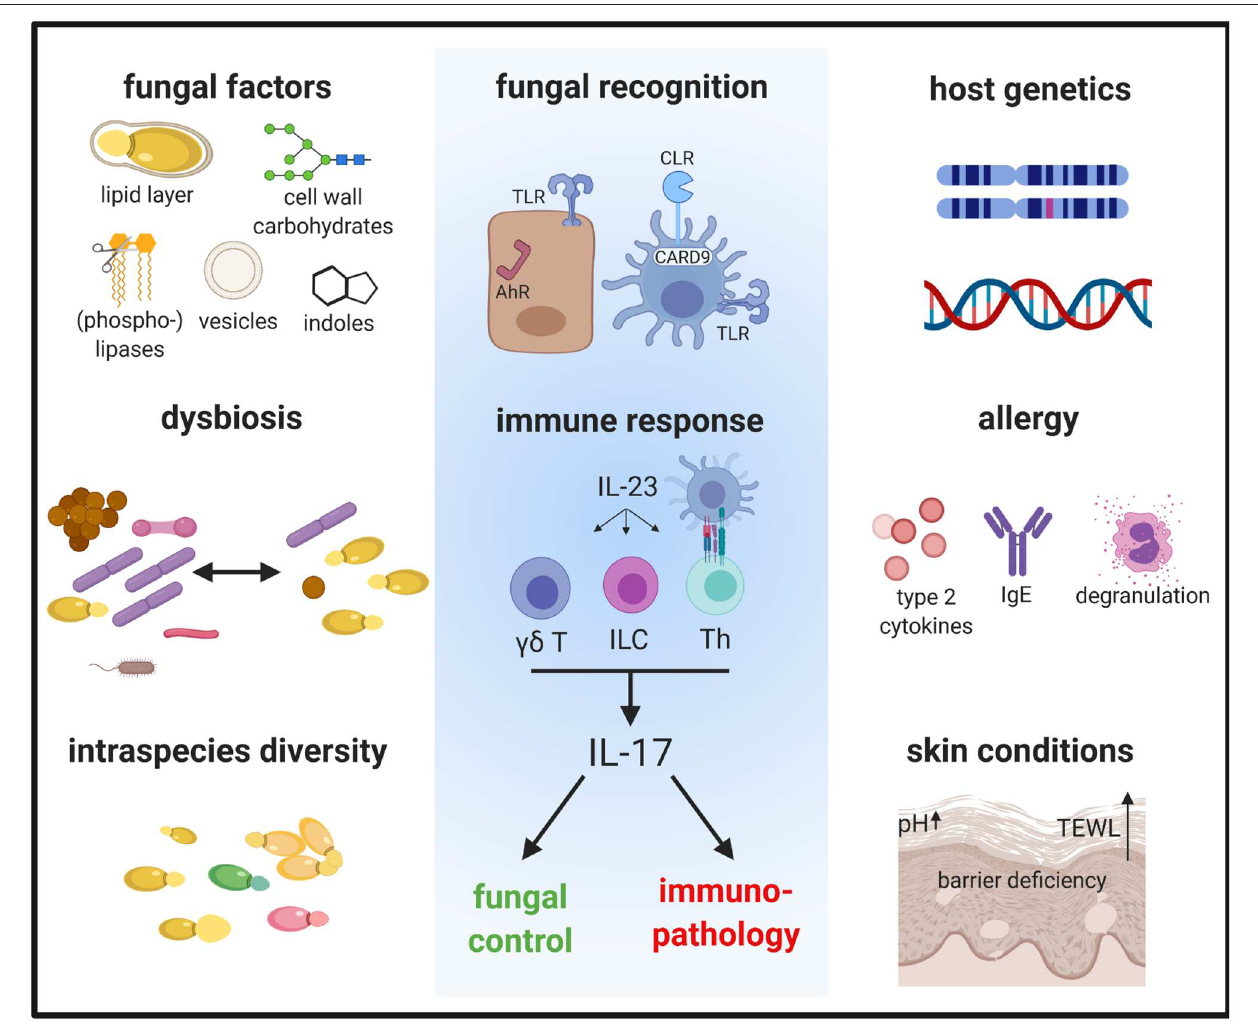
FIGURE 1 | The immune response to Malassezia is influenced by fungal factors including cell wall constituents and secreted components, inter- and intraspecies variations and host factors such as genetics and skin or systemic predisposing conditions. These factors determine how Malassezia is recognized by the host and in turn how the host responds to the fungus. The antifungal response is characterized by the activation of the IL-23/IL-17 axis, which not only controls fungal growth but can also mediate immunopathology. AhR, aryl hydrocarbon receptor; CLR, C-type lectin receptor; γδ T, γδ T cells; ILC, innate lymphoid cells; TLR, Toll-like receptor; TEWL, trans-epidermal water loss; Th, T helper